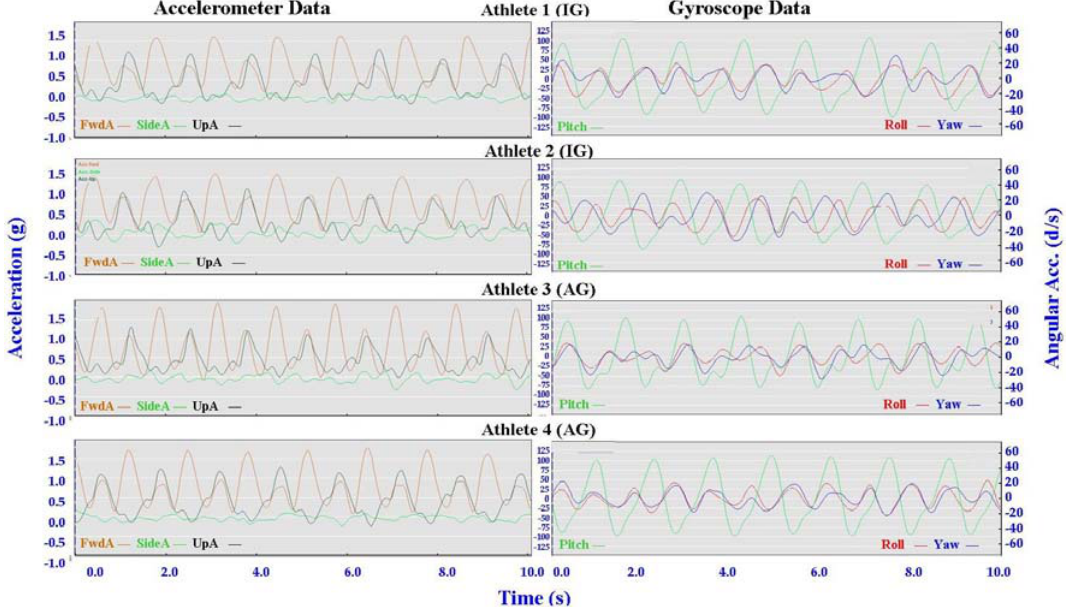
Figure 11. Comparison of Kick Double Pole (KDP) gyroscope and accelerometer traces for four athletes (two from the IG and two from the